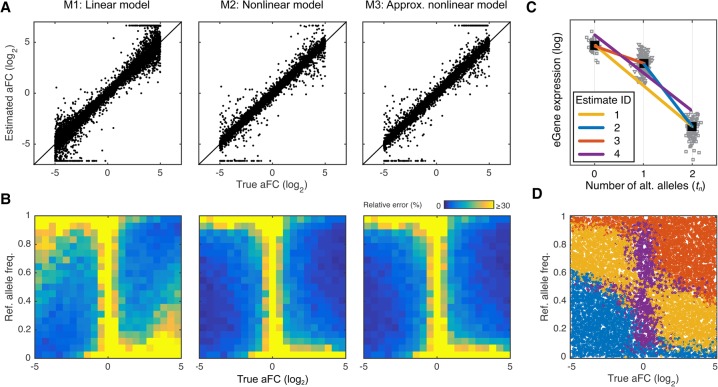
Comparison of the aFC estimation methods using simulated data. We simulated 10,000 eQTLs with noise (40% coefficient of variation), and uniformly selected log2 aFC (range: [−5,5]), and reference allele frequency (range: [0,1]). (A) True aFC used in simulation versus identified values using linear model (M1), nonlinear model (M2), and the nonlinear model approximation (M3). At this level of noise, M2 performed the best, with M1 and M3 having RMSDs of 164% and 110% of M2. (B) Quality of the effect size estimates as a function of allele frequency and the true effect size, evaluated by average error relative to the true log2 aFC. All three estimates, and particularly M1, deteriorate when the lower expressed allele is the minor allele. (C,D) Schematic representation of the nonlinear model approximation method (Box 3) based on four different candidate estimates (C), and the selected estimate with minimum residual variance for each simulated eQTL as a function of reference allele frequency and the true aFC (D).